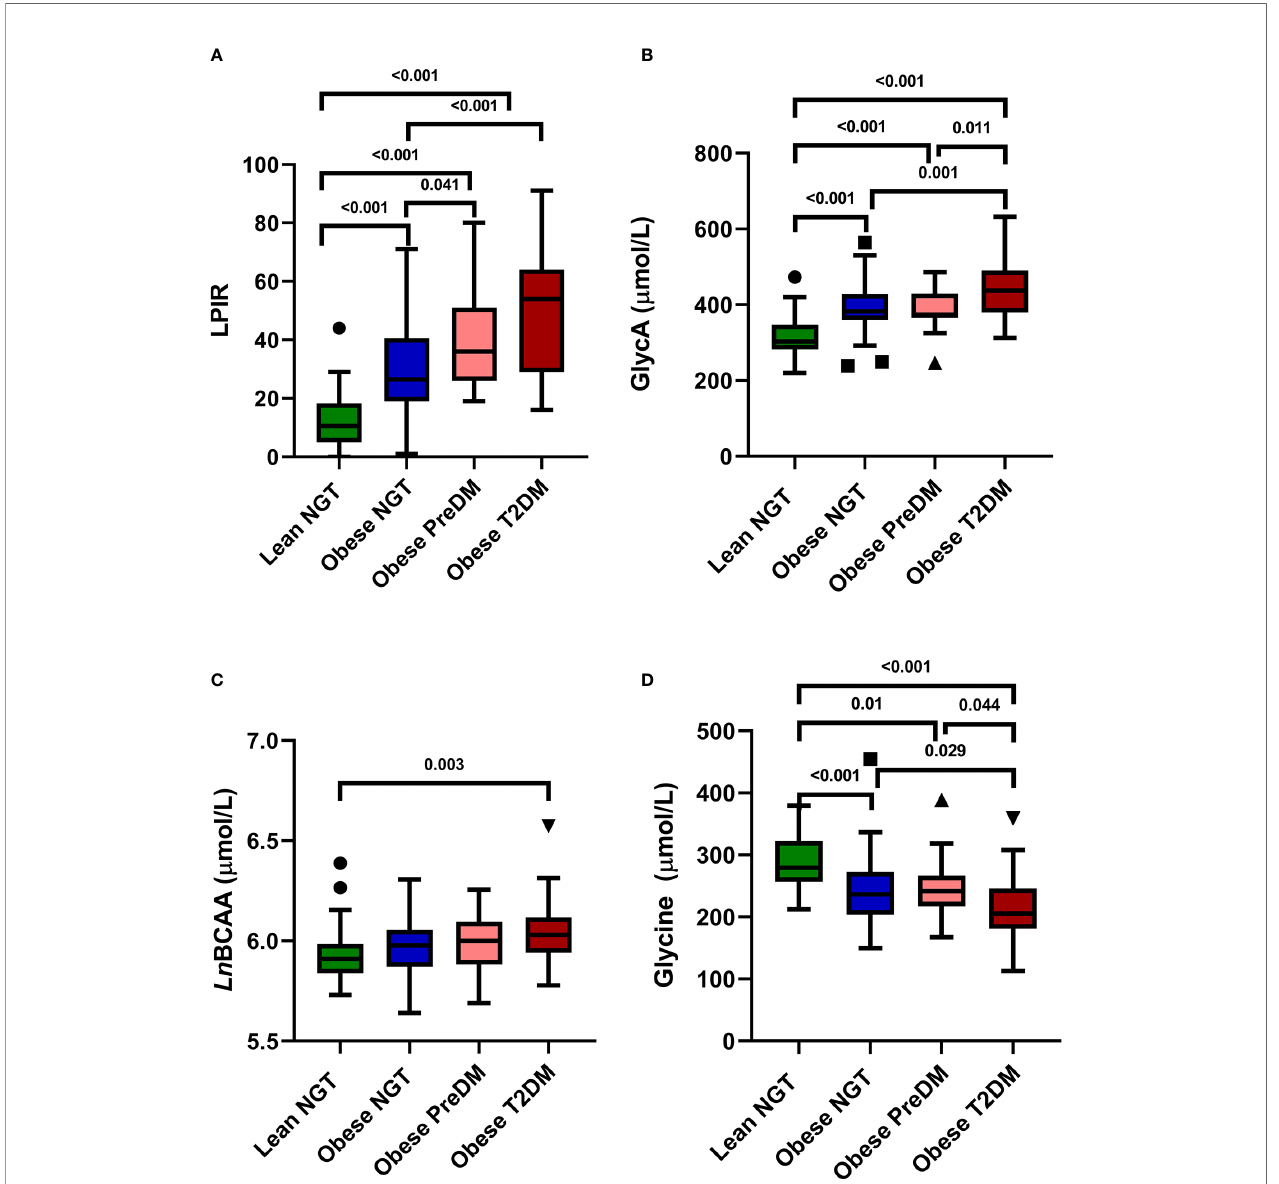
FIGURE 2 | NMR Biomarkers in Youth. Tukey Box and Whisker plots of LPIR score (A) GlycA (B) Total Ln BCAA (C) and Glycine concentrations (D) in lean NGT (green), obese NGT (blue), obese PreDM (pink) and obese T2DM (red). Groups were compared with one-way ANOVA with Bonferroni corrections. LPIR, lipoprotein